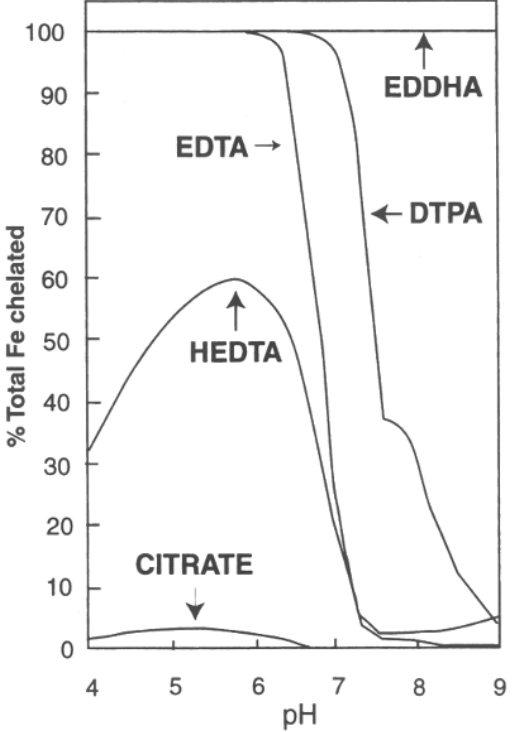
Figure 4. A pH comparison of chelators and their proportion of Fe chelated [26]; Ethylenediaminediaminedi-o-hydroxyphenylacetic acid (EDDHA; C 18 H 20 O 6 N 2 ), Ethylenediamintetraacetic acid (EDTA, C 10 H 16 O 6 N 2 ), Diethylenetriaminepentaacetic acid (DTPA; C 14 H 23 O 10 N 3 ), Hydroxyethylenediaminetriacetic acid (HEDTA; C 10 H 18 O 7 N 2 ), CITRATE (C 6 H 5 O 73 − ).